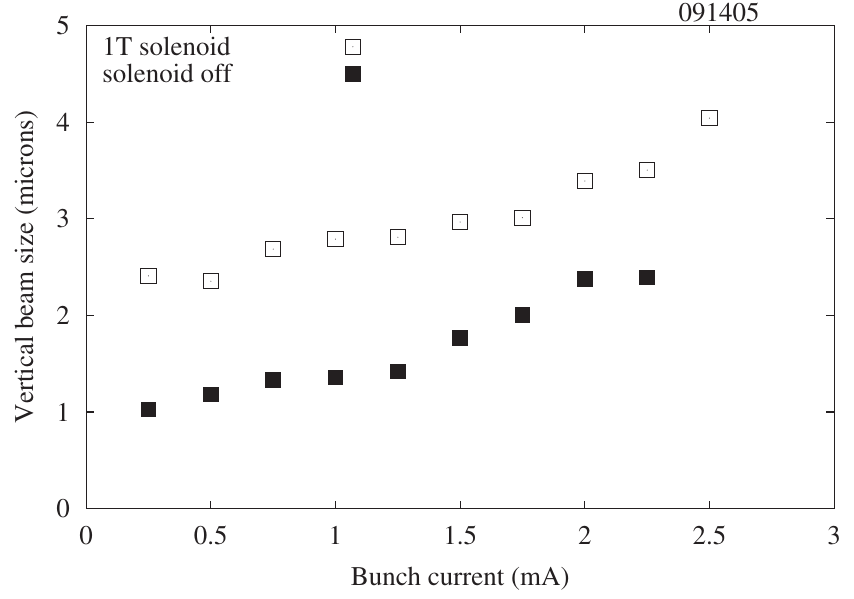
FIG. 13. Fitted vertical beam size for the solenoid off optics and standard cesr-c optics with 1 T solenoid.